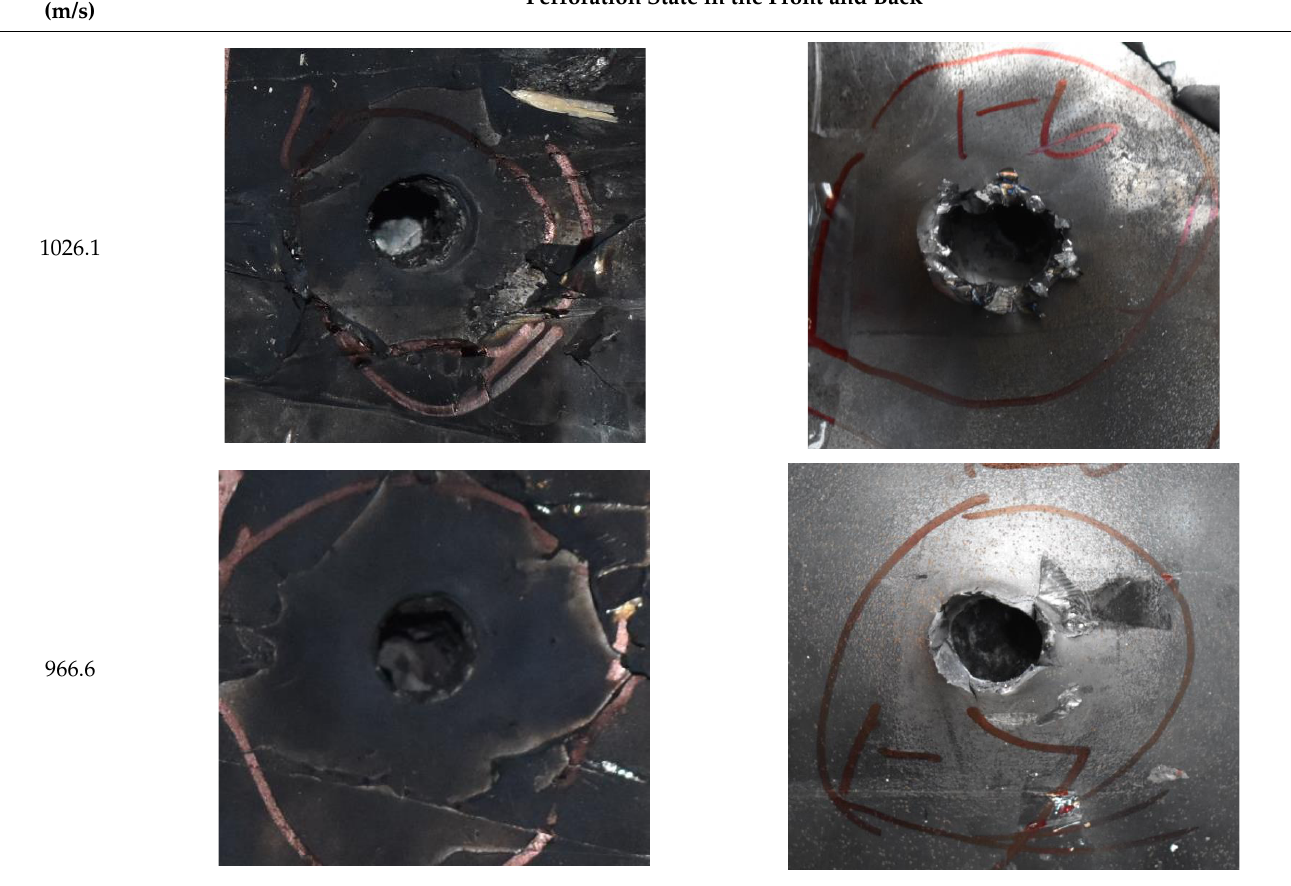
Table 2. Perforation results in the experiment.